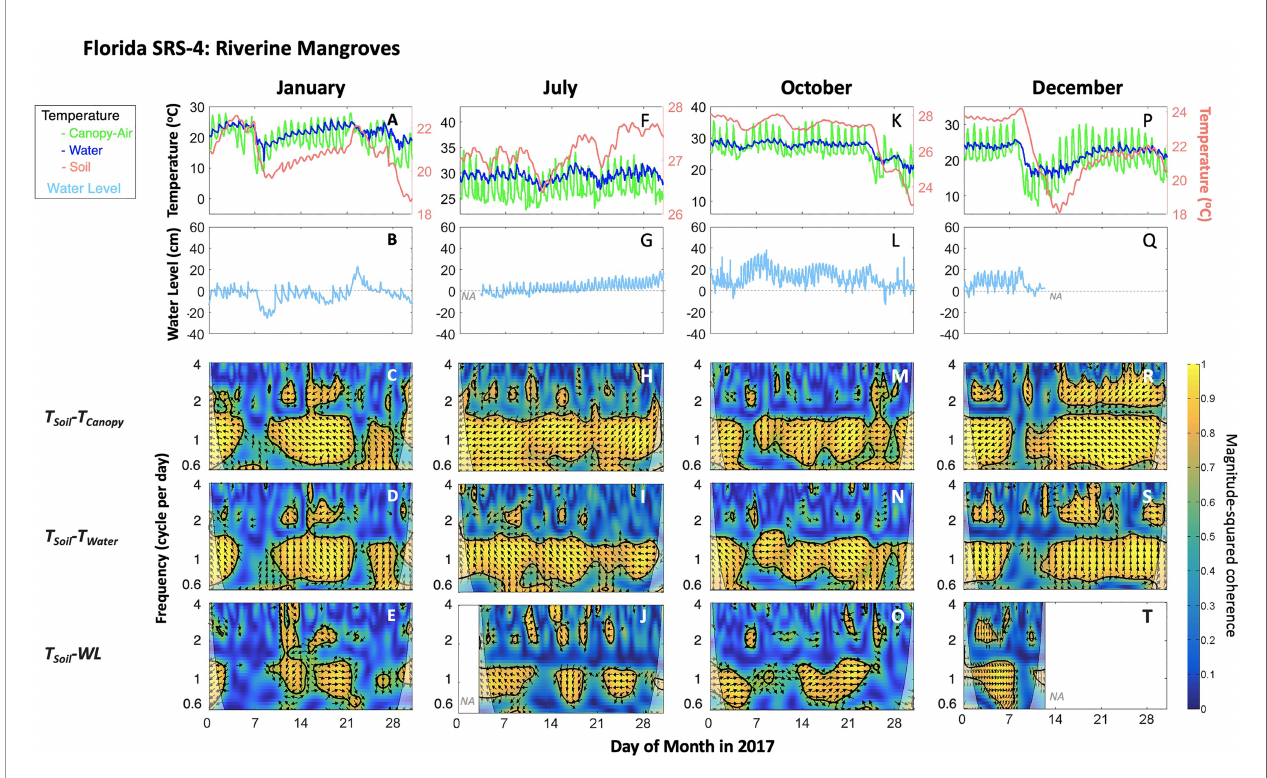
FIGURE 8 | As in Figure 7 , but for riverine mangroves at SRS-4, Shark River estuary, Florida Coastal Everglades, South Florida during 2017. “ NA ” indicates data were not available due to the limited sensor memory or power